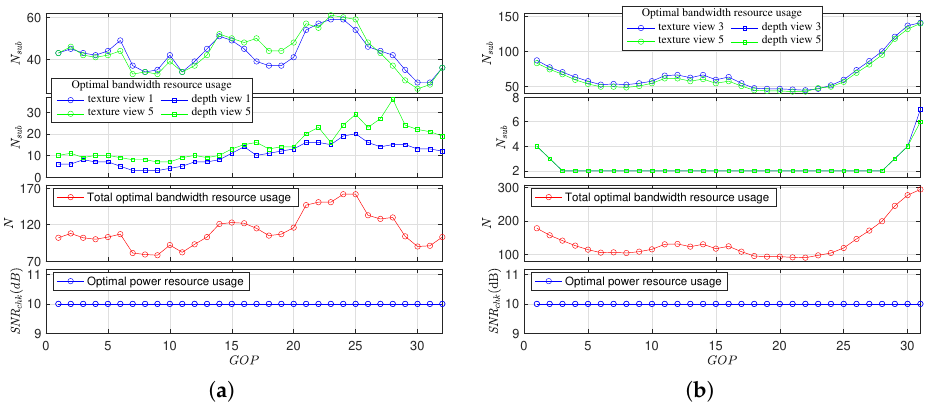
Figure 5. Bandwidth usage for texture and depth map of 3D video sequences: ( a ) Kendo; ( b ) Poz-